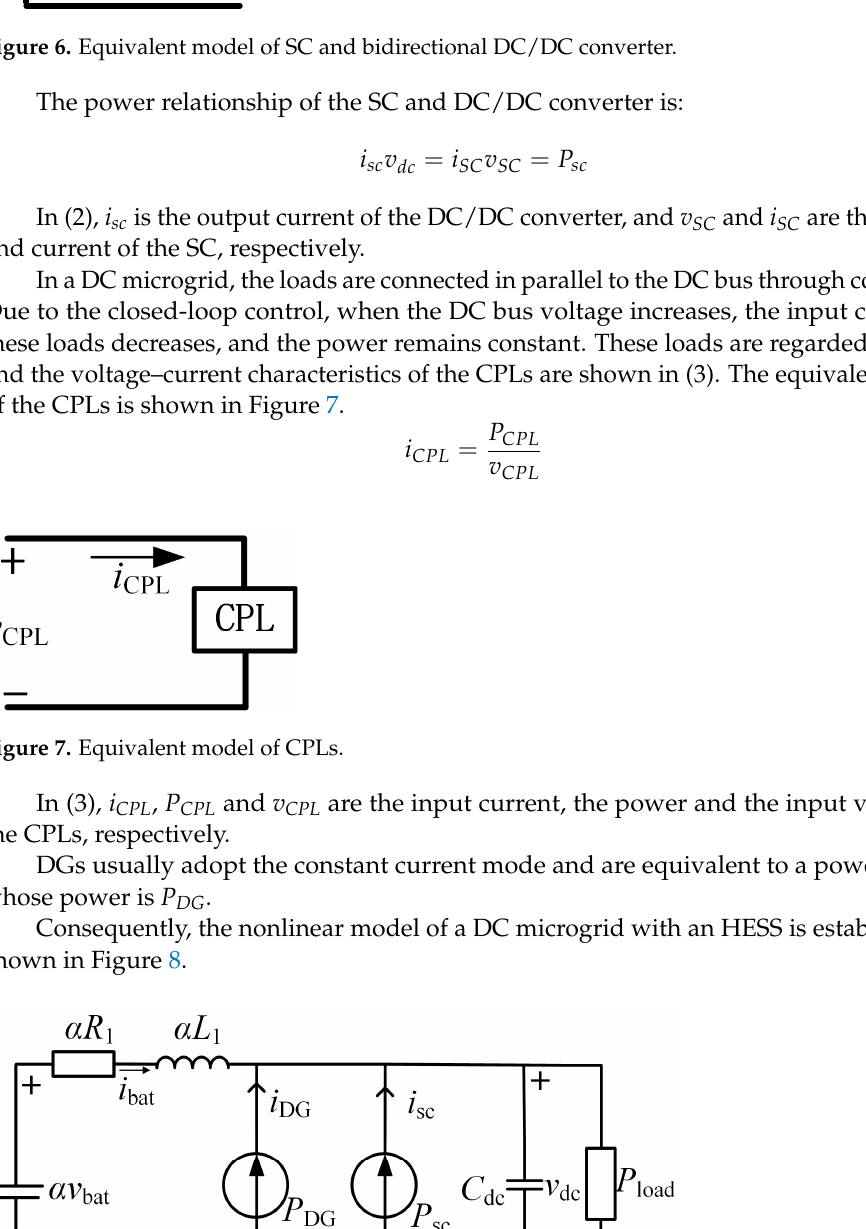
Figure 6. Equivalent model of SC and bidirectional DC/DC converter.